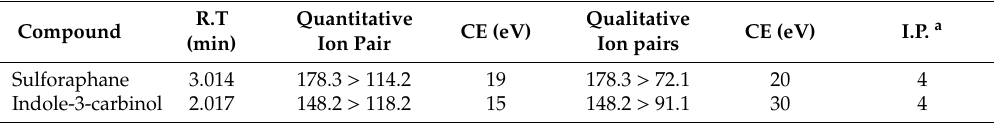
Table 5. Mass scan parameters and retention time for sulforaphane and indole-3-carbinol.